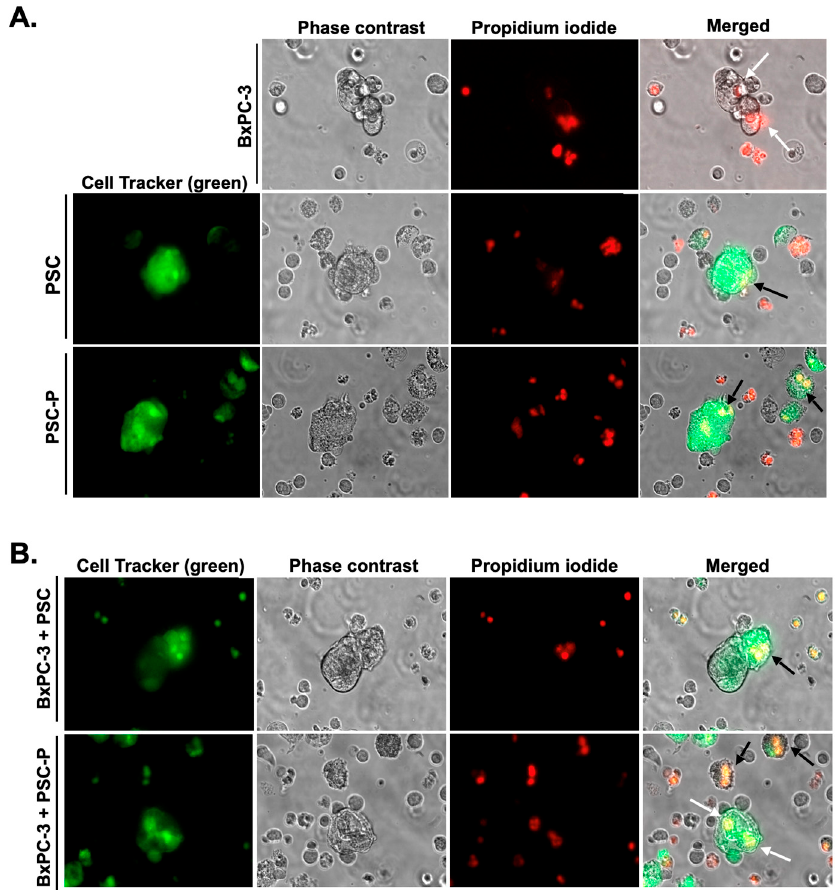
Figure 5. Increased PI posivity were observed in the spheroids formed by PSC ‐ P cells. In order to observe cell death in PSC and PSC ‐ P cells, the cells were stained with CellTracker green and then cultured alone ( A ) or with non ‐ stained BxPC ‐ 3 cells ( B ) for 4 days to form spheroids. Following 24 h exposure to NK ‐ 92 cells, the cells were stained with PI. White arrows show cell death in BxPC ‐ 3 cells, while black arrows represent cell death in PSC and PSC ‐ P cells.